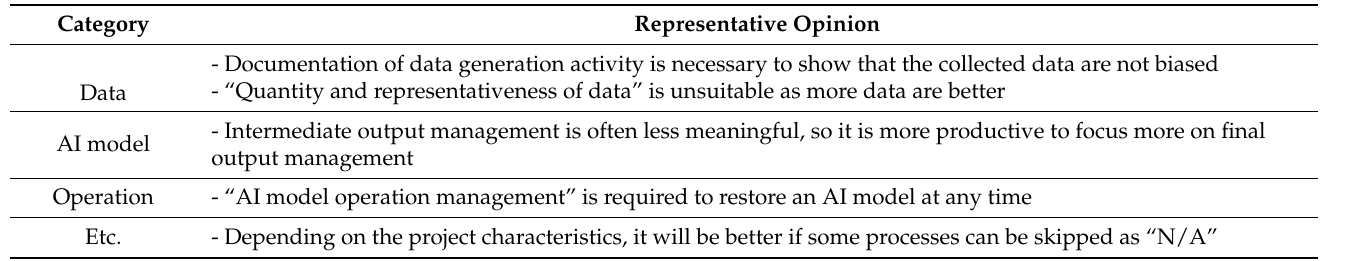
Table 1. Representative opinions collected and reflected through a survey.